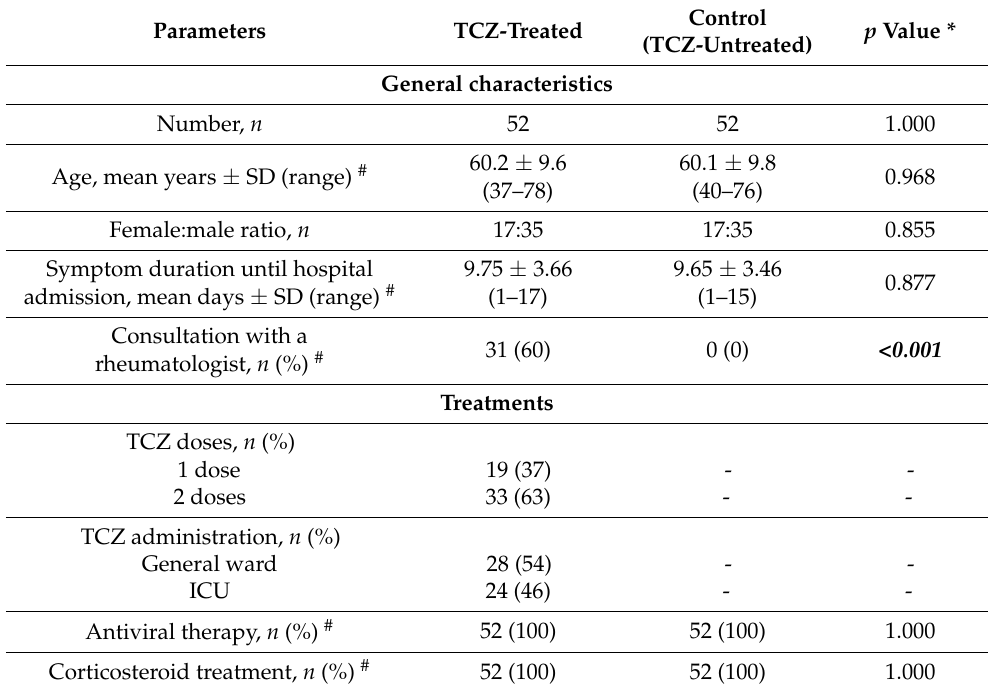
Table 1. Baseline characteristics of TCZ-treated and control